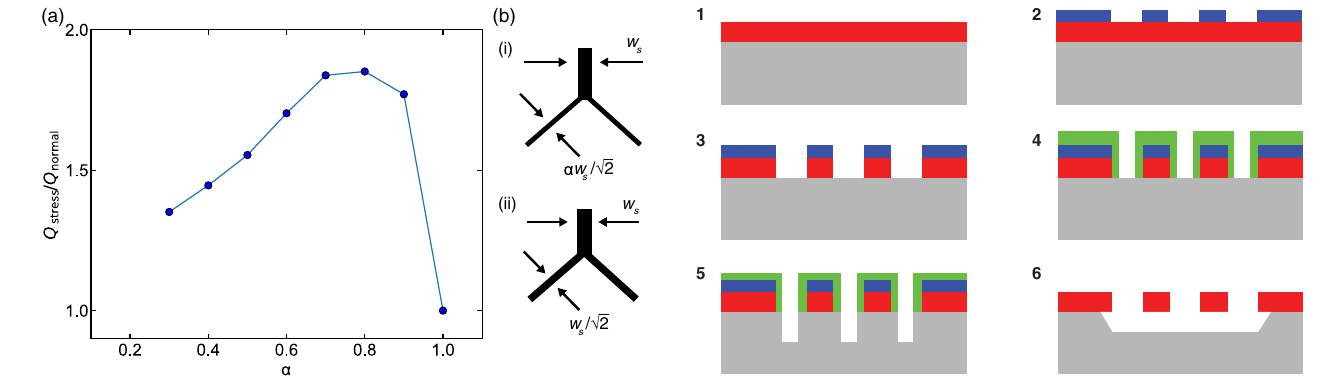
FIG. 10. Fabrication process flow. (1) LPCVD thin film deposition of Si 3 N 4 on Si (red on gray). (2) ebeam lithography on Si 3 N 4 wafer using FOX16 (blue). (3) Dry etching of Si 3 N 4 . ). normal (4) Recess ebeam (green corresponds to the second layer of FOX16). (5) DRIE etching of Si substrate. (6) KOH undercut and CPD.